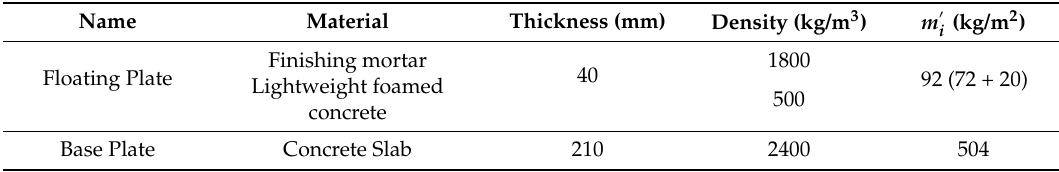
Table 11. Material properties of the idealized two-plate system.